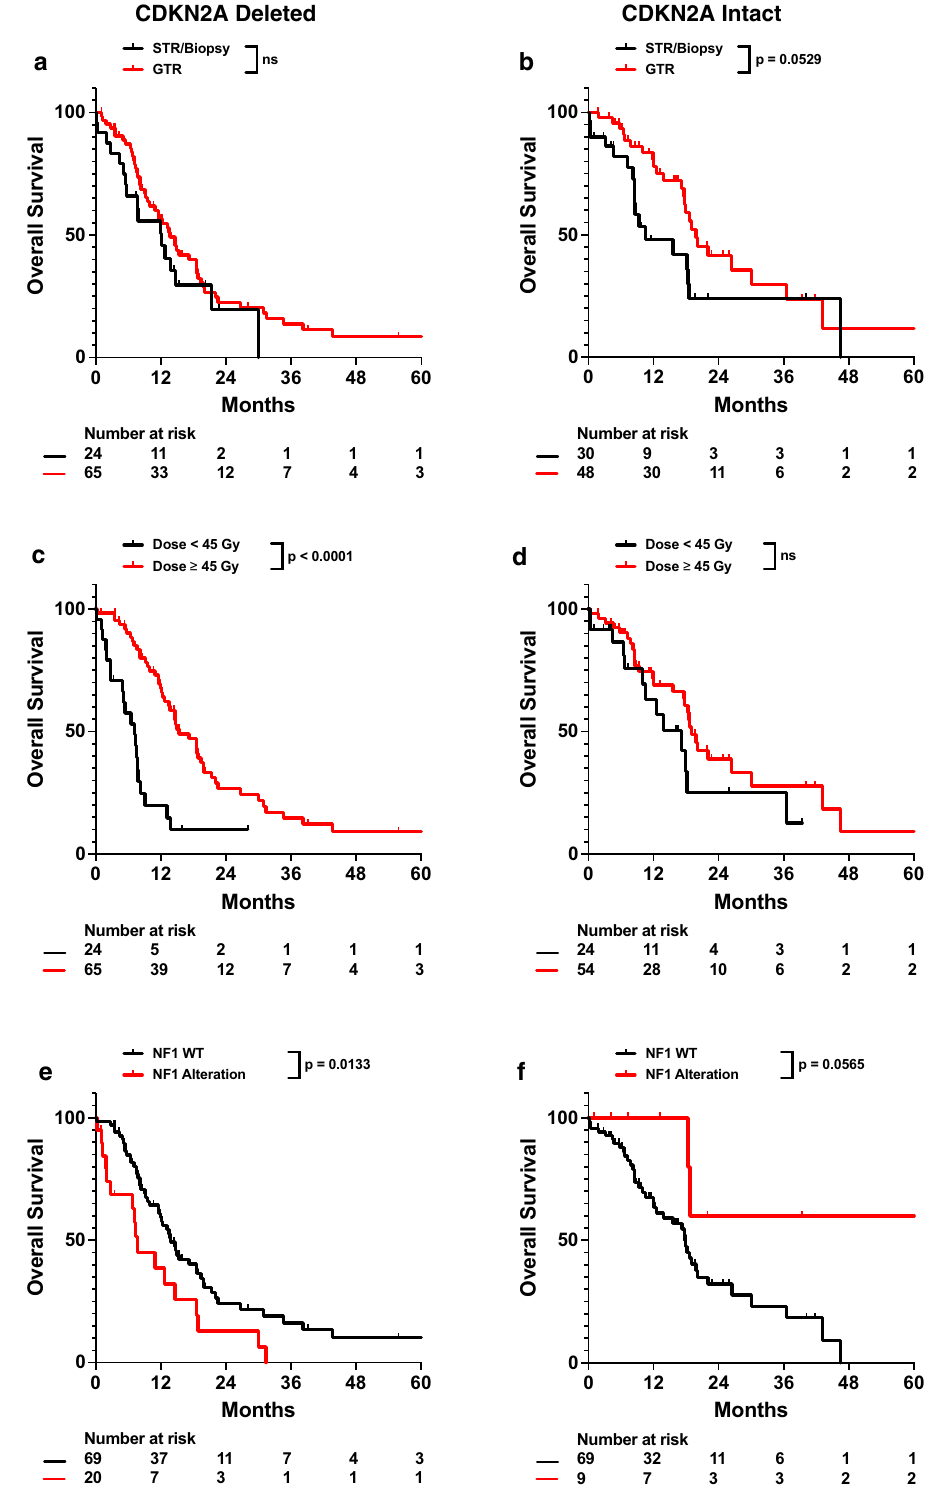
Fig. 3 Univariate impact of total resection, radiation dose, and NF1 alteration on OS in CDKN2Adel and CDKN2Aint cohorts. Kaplan–Meyer plots of OS comparing patients with different ( a, b ) total resection status, ( c, d ) radiation dose, or ( e, f ) NF1 alteration status in CDKN2Adel and CDKN2Aint patients are shown. Statistical analysis was performed using Cox Proportional Hazards tests. OS, overall survival;